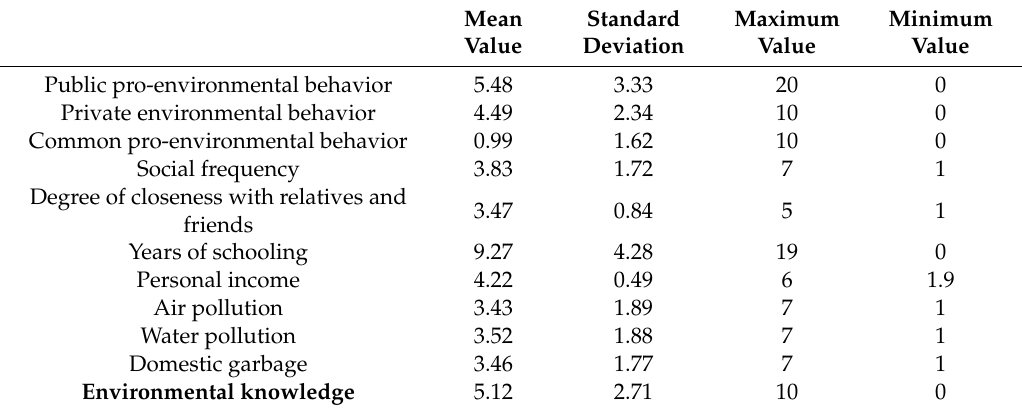
Table 2. Descriptive statistics of